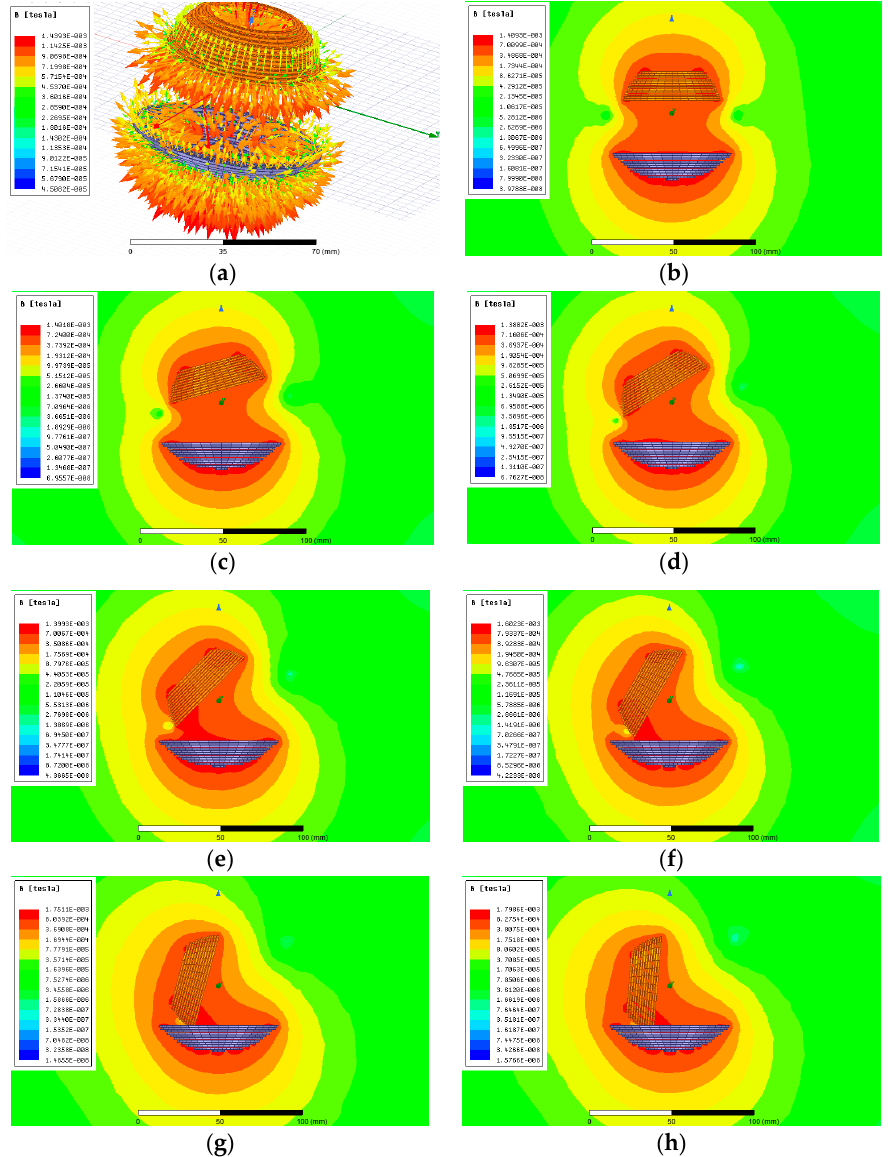
Figure 13. The magnetic field density of the optimal model at different angular misalignments: ( a ) magnetization direction; ( b ) α = 0°; ( c ) α = 15°; ( d ) α = 30°; ( e ) α = 45°; ( f ) α = 60°; ( g ) α = 75°; ( h ) α = 85°.